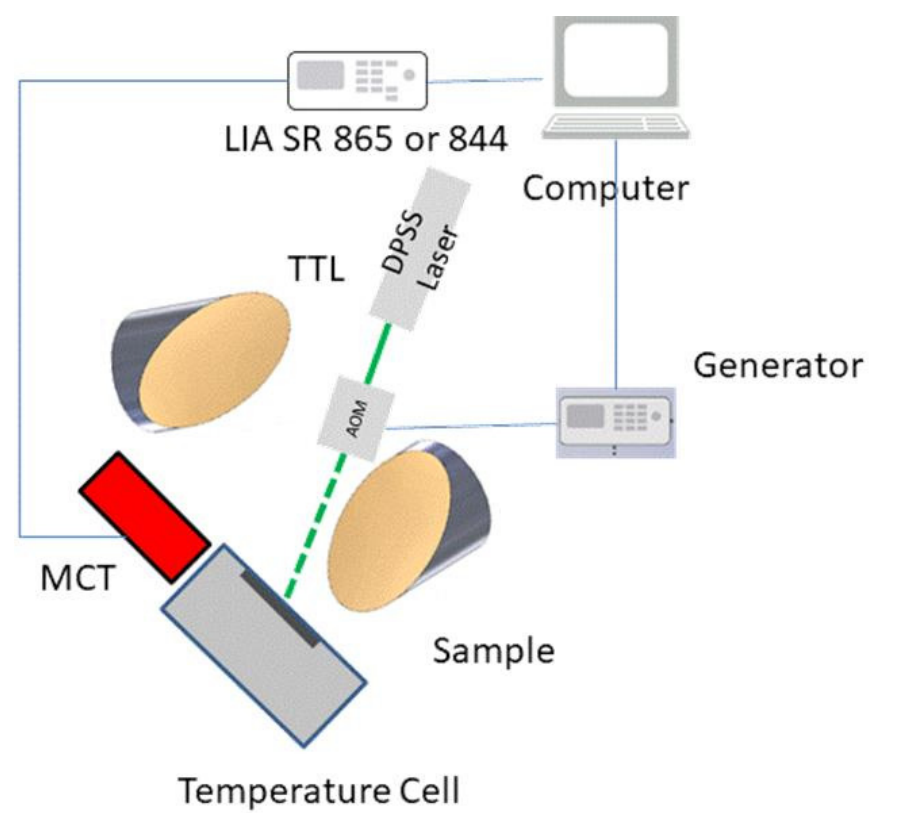
Figure 1. Frequency-domain photothermal infrared radiometry set-up with temperature cell. The beam size was 1.8 mm.